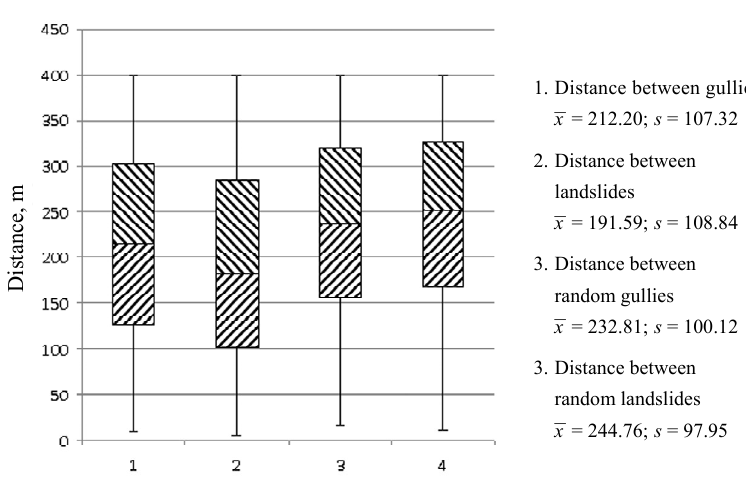
Table 3. Calculated sediment volume transport from slopes of the Gauja River valley The 2 km zone, including the slope